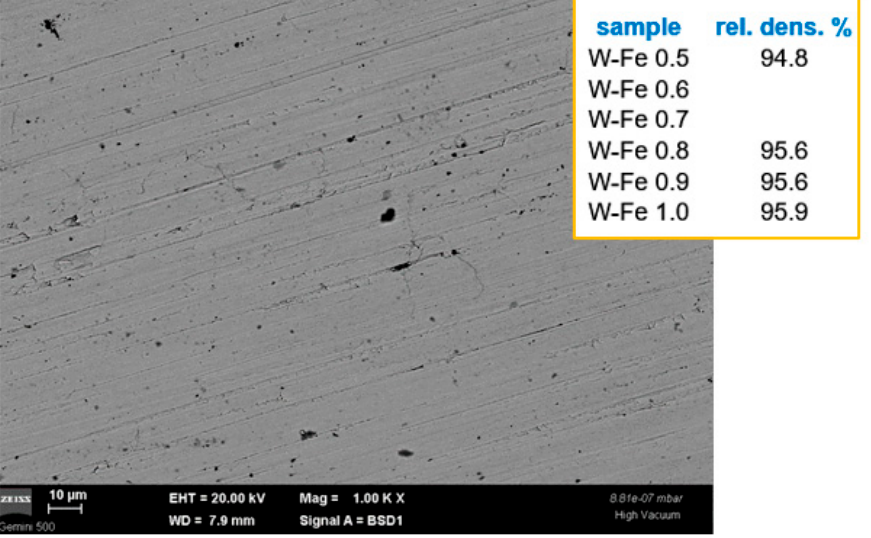
Figure 7. Cross-section SEM image obtained using a backscattered electron detector for W-Fe materials. Dispersion location at W grain boundaries can be observed, together with the presence of pores. The inset summarizes the density values of these materials.